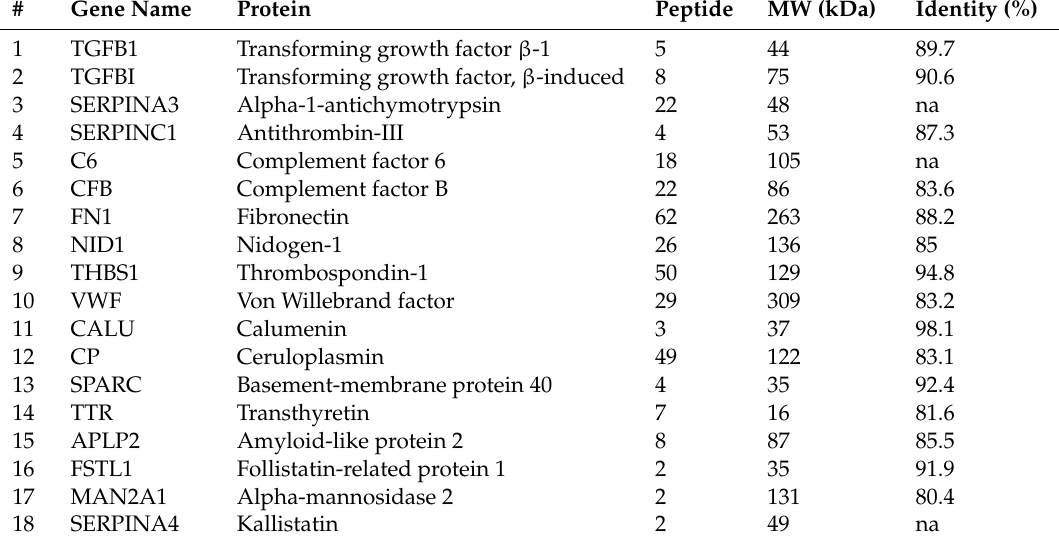
Table 1. Human proteins presenting a high level of similarity with their mouse homologs. Retained human proteins for their high level of identity (minimum 80%) between mouse and human proteins after in silico amino acid sequence alignment. Listed proteins correspond to protein clusters or individual proteins. The peptide column indicates the number of peptides identified by MS analysis. MW: molecular weight; identity indicates the percentage of common amino acid sequences between human and